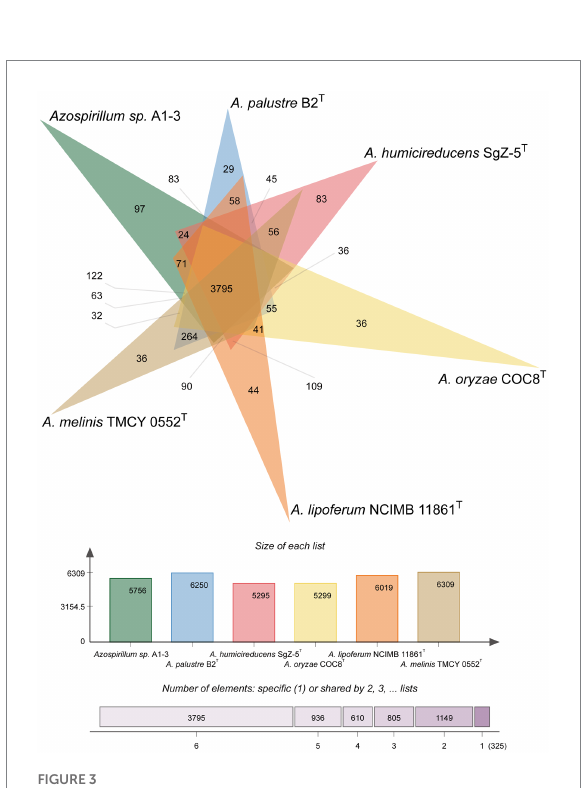
FIGURE 3 Venn diagram analysis of Azospirillum sp. A1-3 and related Azospirillum